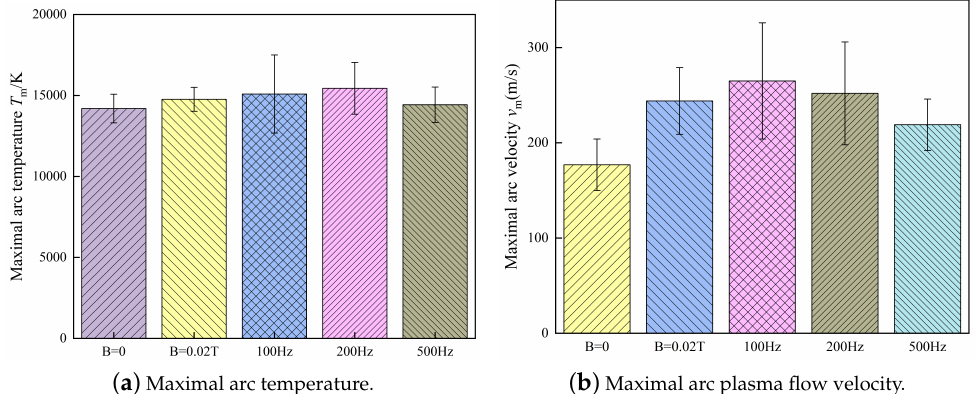
Figure 10. Maximal arc temperature and flow velocity in high-current GMAW with EAMFs at di ff erent alternating